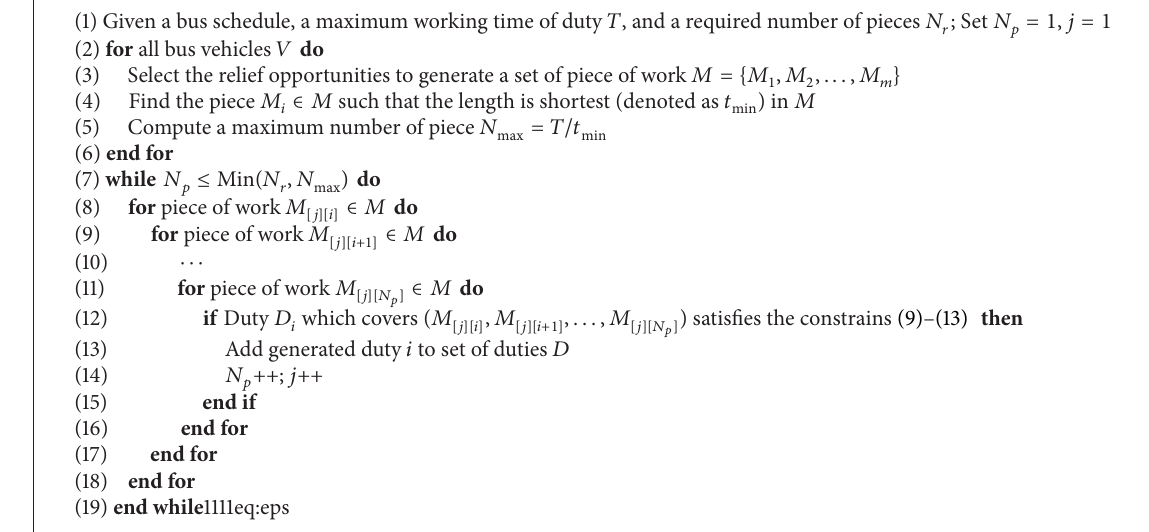
Algorithm 1: Generation of all valid potential